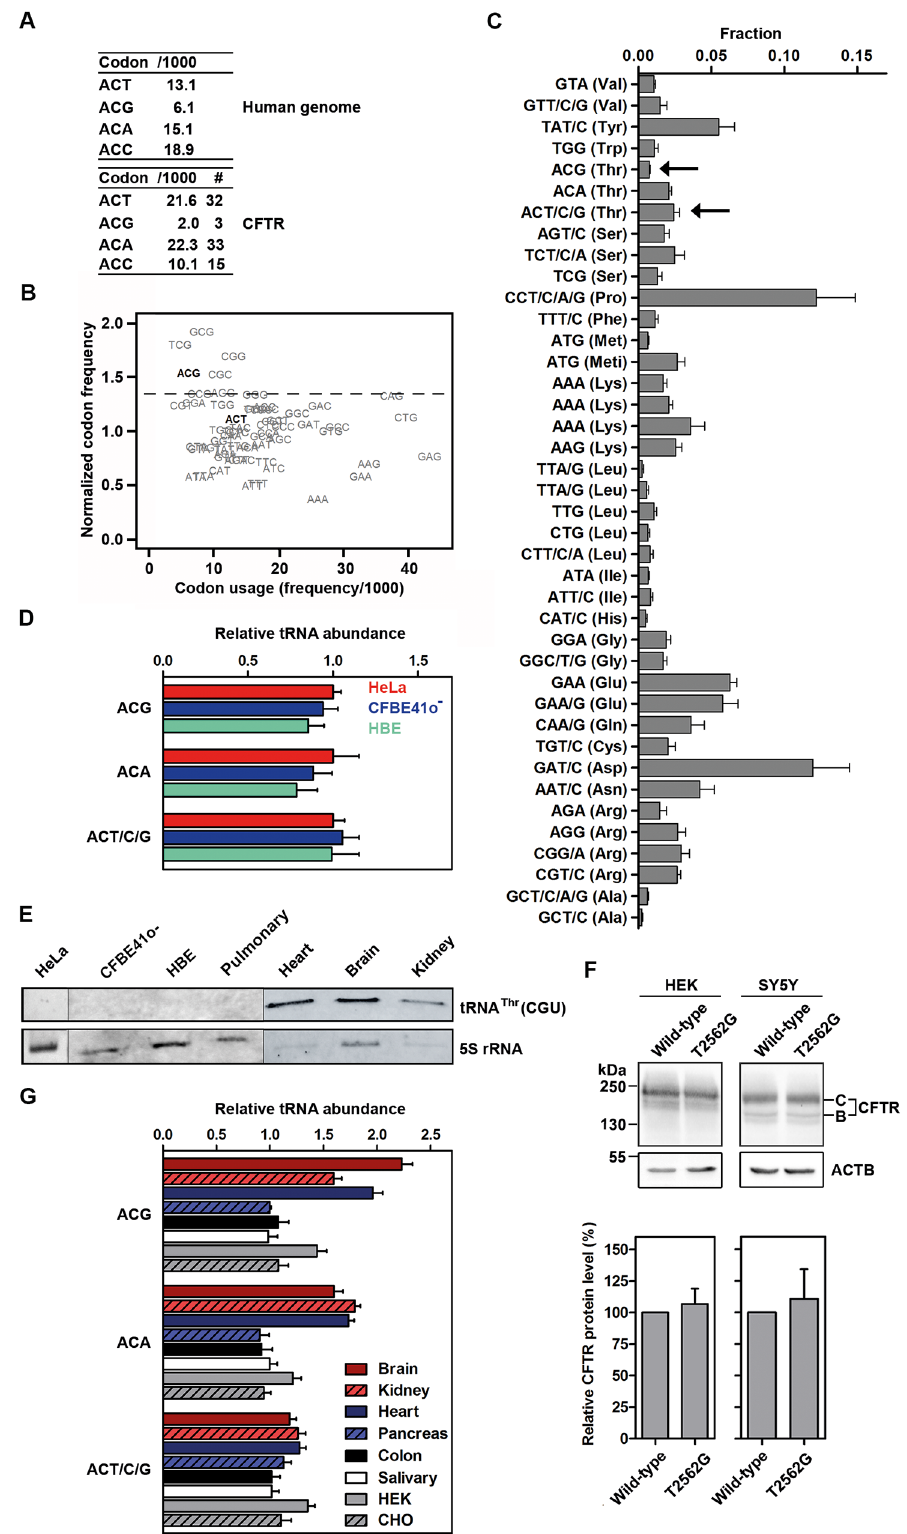
Fig 4. tRNA Thr (CGU) level is very low in CFBE41o - , primary human bronchial epithelial (HBE) cells, and pulmonary tissues. ( A ) Frequency of the Thr codons per thousand(/1,000) and as absolute numbers (#). ( B ) Ribosome dwellingoccupancy at the ACG codon is highestin CFBE41o - cells. The graphshows the